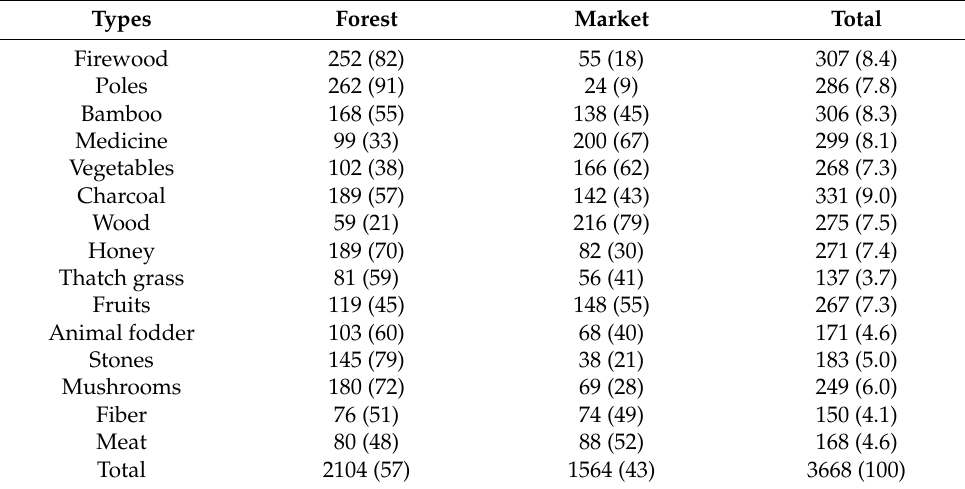
Table 4. Types of forest products by the local people